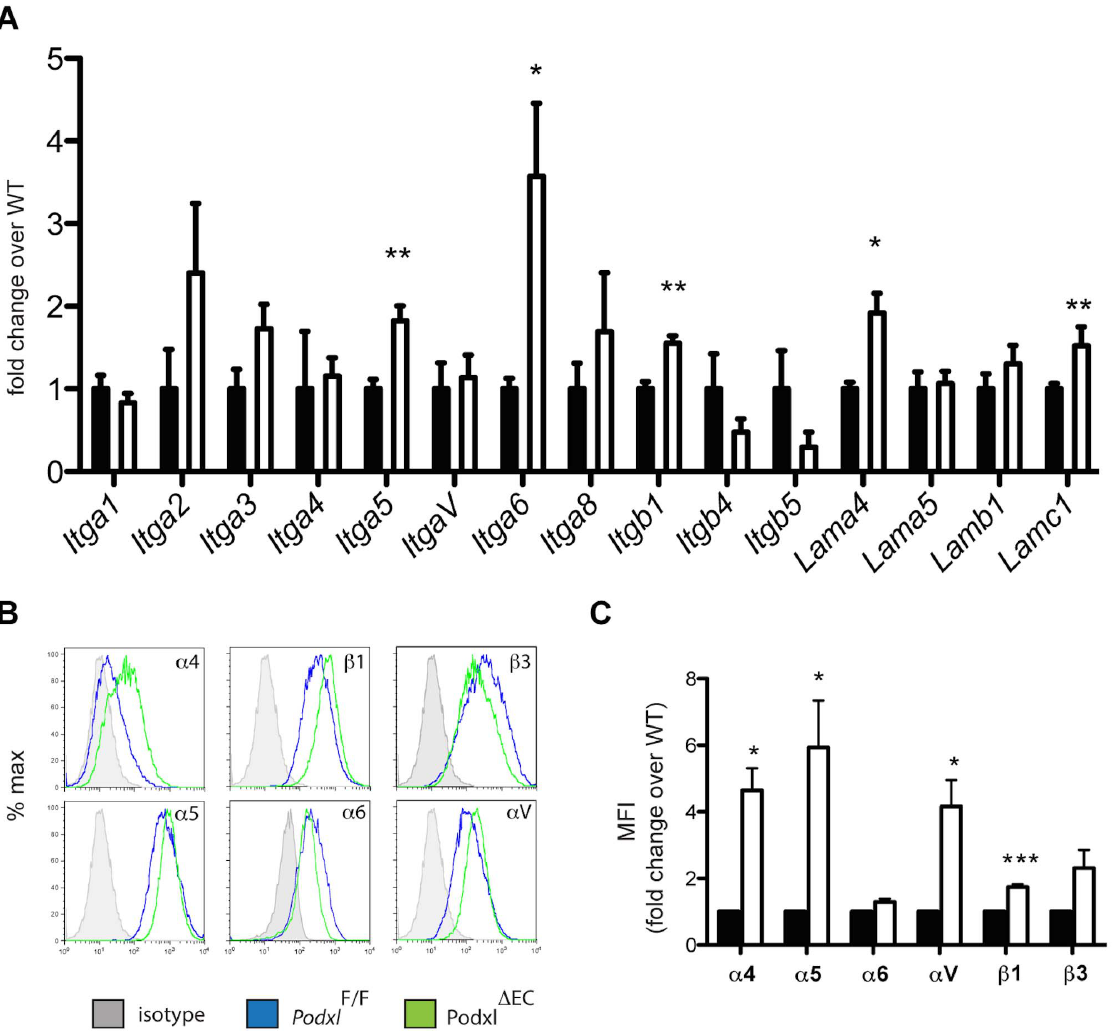
Figure 7. Podocalyxin deletion results in altered integrin and laminin expression in primary lung endothelial cells. ( A ) Integrins gene expression in Podxl F/F (black bars) and Podxl D EC (white bars) cultured lung mEC (results are the mean of 3 independent mEC primary cultures per genotype). ( B ) Cell surface expression of integrins on lung mECs isolated from Podxl F/F (blue line) and Podxl D EC (green line) mice. Shown are representative histograms from flow cytometric assays from one experiment. ( C ) Surface expression levels of integrins were determined by flow cytometry using the mean fluorescence intensity (MFI) of the integrin staining in primary mEC cultures. The mean change in the MFI of Podxl D EC mECs (white bars) compared to Podxl F/F mEC (black bars, normalized to 1) are from 4 independently derived mEC cultures. Error bars = SEM, *Significantly different with P , 0.05 or ***significantly different with P , 0.005 using one-sample t test with hypothetical value set to 1 (normalized control).